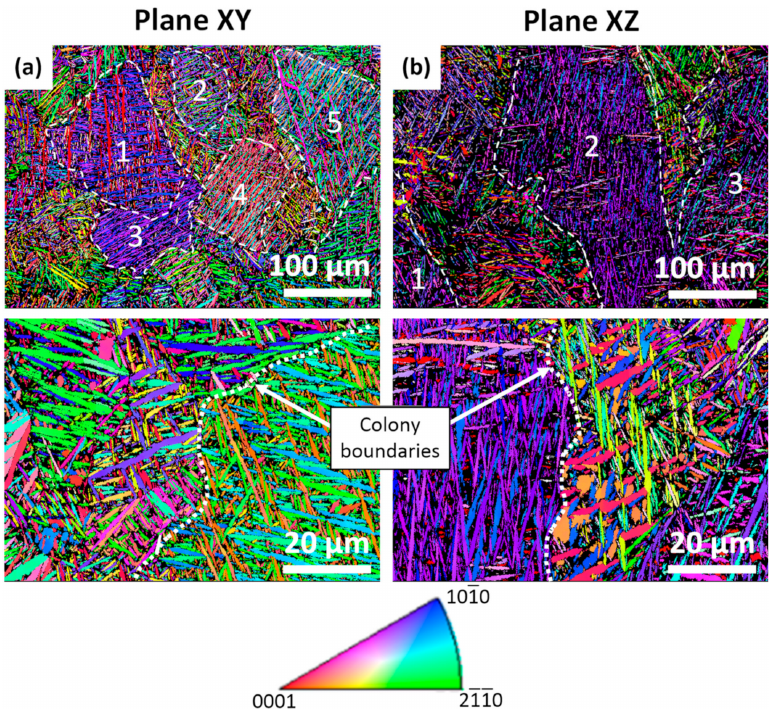
Figure 6. AB specimens: EBSD IPF orientation maps for the XY ( a ) and XZ ( b ) planes with low and high magnifications; numbers 1, 2, 3, 4, and 5 correspond to visible colonies formed in the